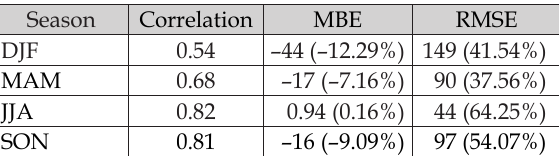
Table 3. a) Correlation value, b) Mean Bias Error (MBE), and c) Root Mean Square Error (RMSE) for seasonal